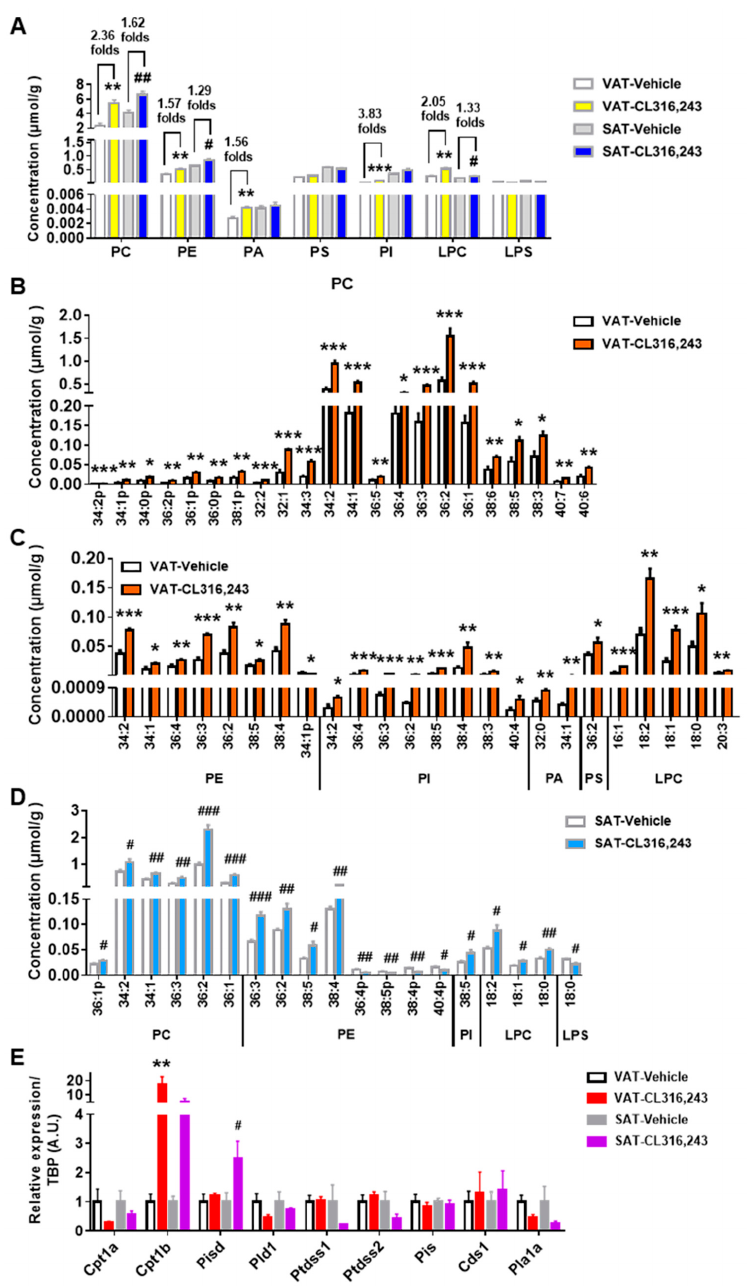
Figure 5. Adrenergic stimulation boosted the abundance of more glycerophospholipids species in VAT than in SAT. ( A ) The overall concentration of classical glycerophospholipids was determined. The abundance of significantly varied ( B ) phosphatidylcholine (PC), and ( C ) phosphatidylethanolamine (PE), phosphatidylinositol (PI), phosphatidic acid (PA), phosphatidylserines (PS), lyso-PC (LPC) species in VAT; ( D ) The obviously changed molecular species of PC, PE, PI, LPC, and lyso-PS (LPS) in SAT. Data are presented as mean ± SEM, n = 5. * P < 0.05; ** P < 0.01; *** P < 0.001 compared with VAT Vehicle group. # P < 0.05; ## P < 0.01; ### P < 0.001 compared with SAT Vehicle group. ( E ) qPCR analysis of carnitine palmitoyltransferase 1a (Cpt1a), carnitine palmitoyltransferase 1b (Cpt1b), phosphatidylserine decarboxylase (Pisd), phospholipase D1 (Pld1), phosphatidylserine synthase 1 (Ptdss1), phosphatidylserine synthase 2 (Ptdss2), phosphatidylinositol synthase (Pis), CDP-diacylglycerol synthase 1 (Cds1), and phospholipase A1 member A (Pla1a) gene expression in VAT and SAT of mice injected with CL316,243. qPCR data are normalized to TBP and presented as mean ± SEM, n = 5. ** P < 0.01 compared with VAT Vehicle group. # P < 0.05 compared with SAT Vehicle